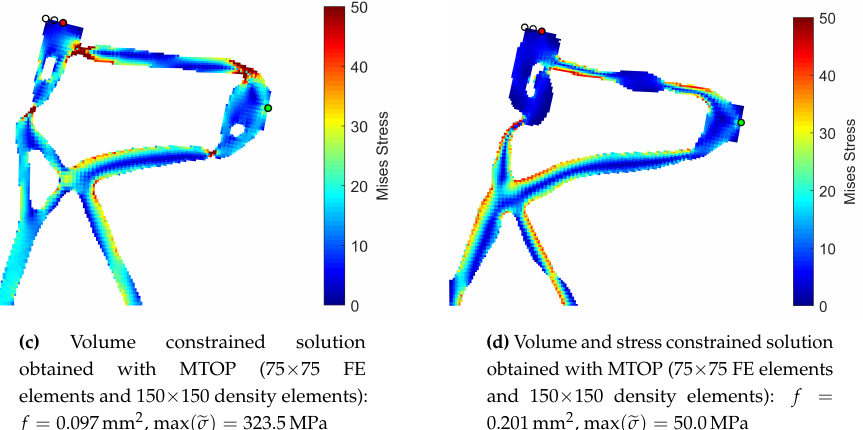
Figure 8. Path generating example solutions with and without multiresolution topology optimization.